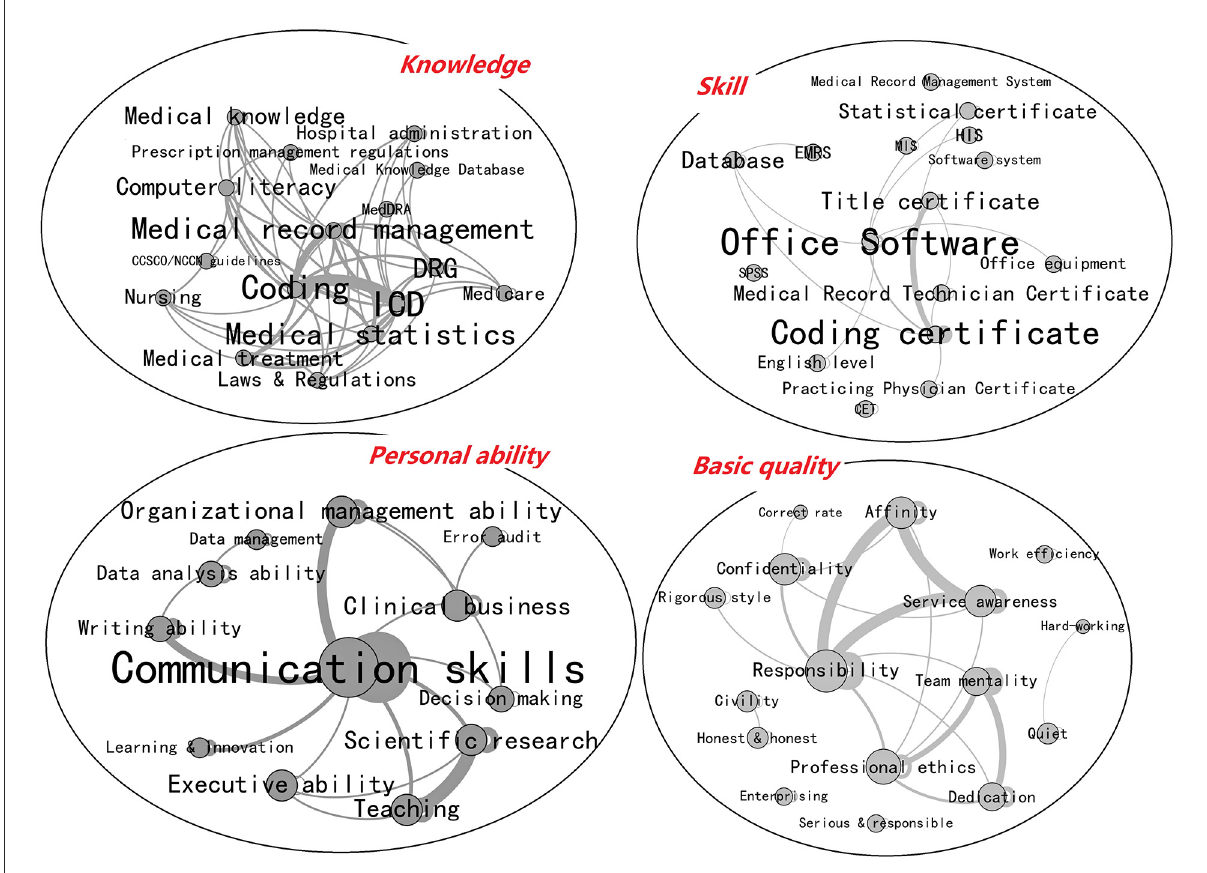
FIGURE4 Visualization map of co-occurrence analysis (Edited in 2021/4,